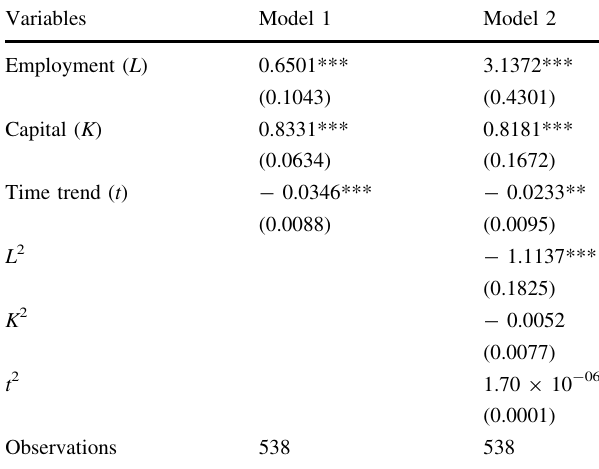
Table 2 Stochastic frontier: production